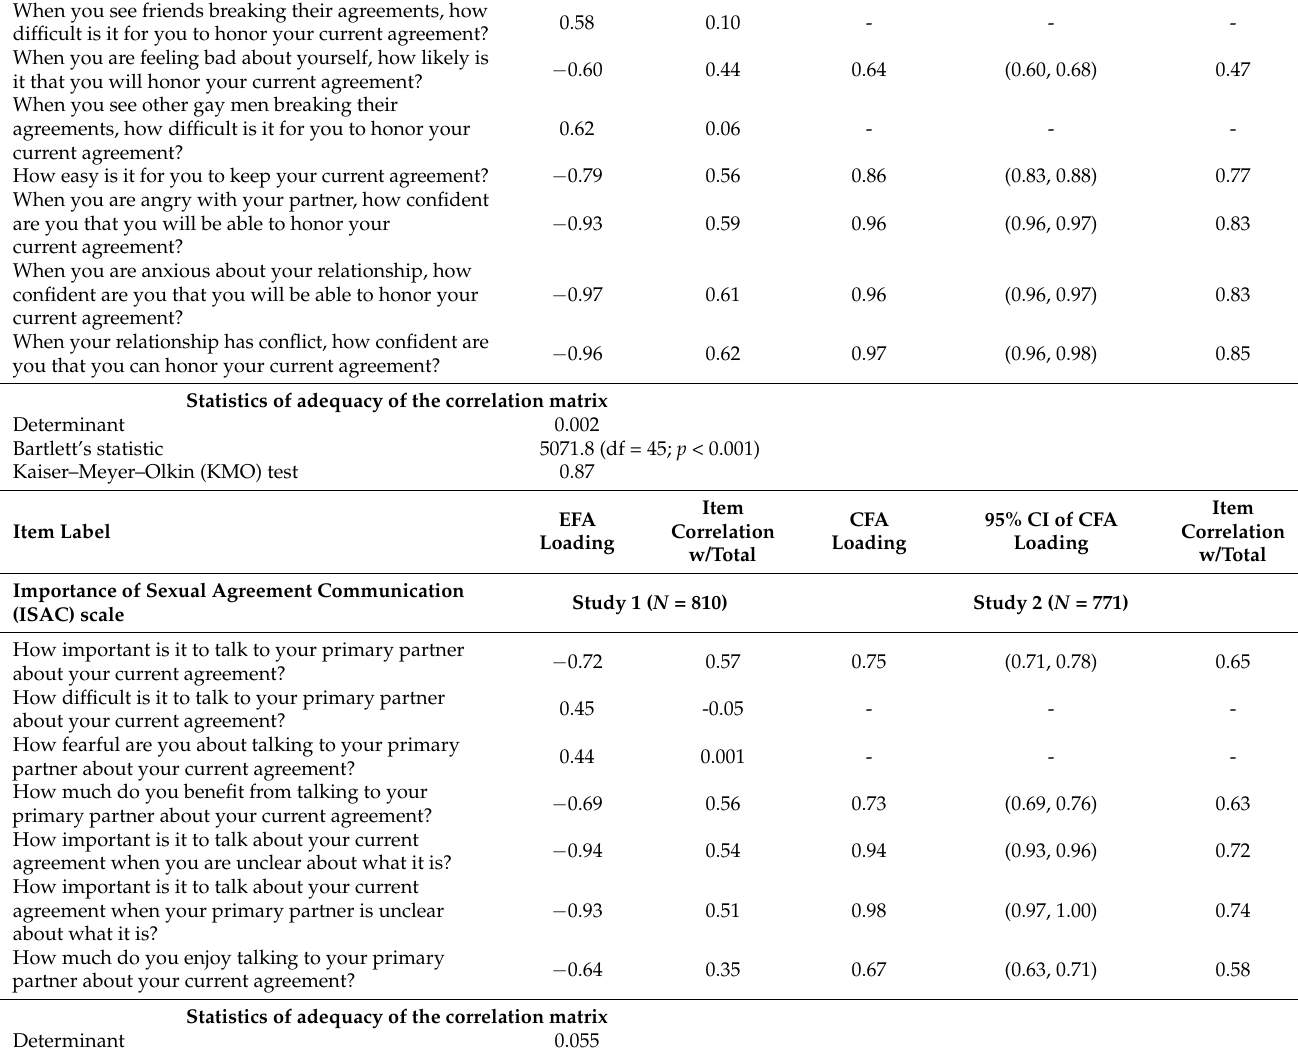
Item EFA CFA 95% CI of CFA Correlation Loading Loading Loading w/Total